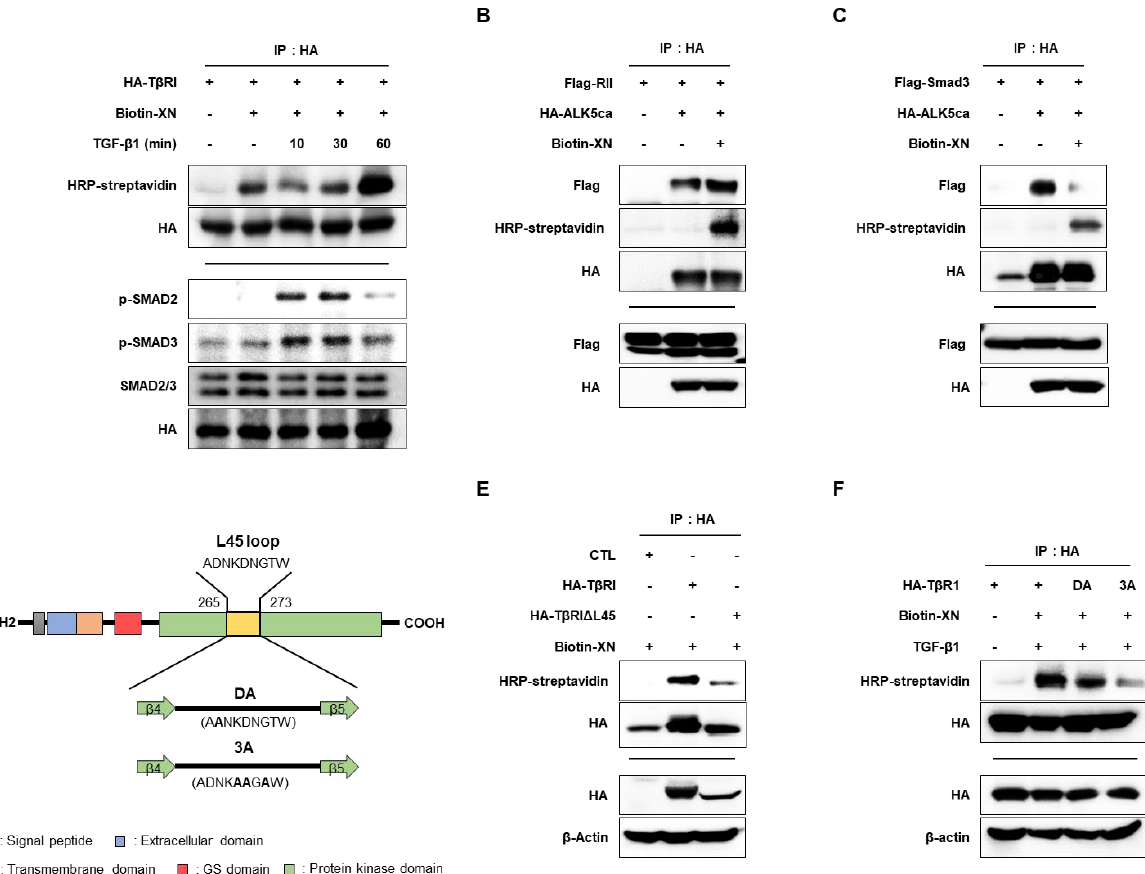
Figure 4. Interfering effect of interaction of T β R1 and Smad3 through binding to T β R1 by XN in SW620 cells. ( A ) HA-T β RI was transfected. IP was performed with anti-HA. IB was performed with HRP-streptavidin, HA, p-Smad2, p-Smad3, Smad2/3, and HA antibody, respectively. ( B ) Flag-RII and HA-ALK5ca were transfected. IP was performed with anti-HA. IB was performed with HRP-streptavidin, HA, and Flag, respectively. ( C ) Flag-Smad3 and HA-ALK5ca were transfected. IP was performed with anti-HA. IB was performed with HRP-streptavidin, HA, and Flag, respectively. ( D ) Protein domain structures of the L45 loop on T β R1. Domains are shown relative to their positions in the amino acid sequences. T β R1 consists of domains that include the signal peptide (gray), extracellular domain (blue), transmembrane domain (orange), GS domain (red), protein kinase domain (green), and L45 loop (yellow). DA, a single mutant (D266A) in ALK5; 3A, triple mutants (D269A, N270A, and T272A) in ALK5. ( E ) HA-T β RI and HA-T β RI ∆ L45 were transfected. IP was performed with anti-HA. IB was performed with HRP-streptavidin, HA, and β -actin. ( F ) Wildtype and mutants (DA and 3A) of T β RI were transfected. IP was performed with anti-HA. IB was performed with HRP-streptavidin, HA, and β